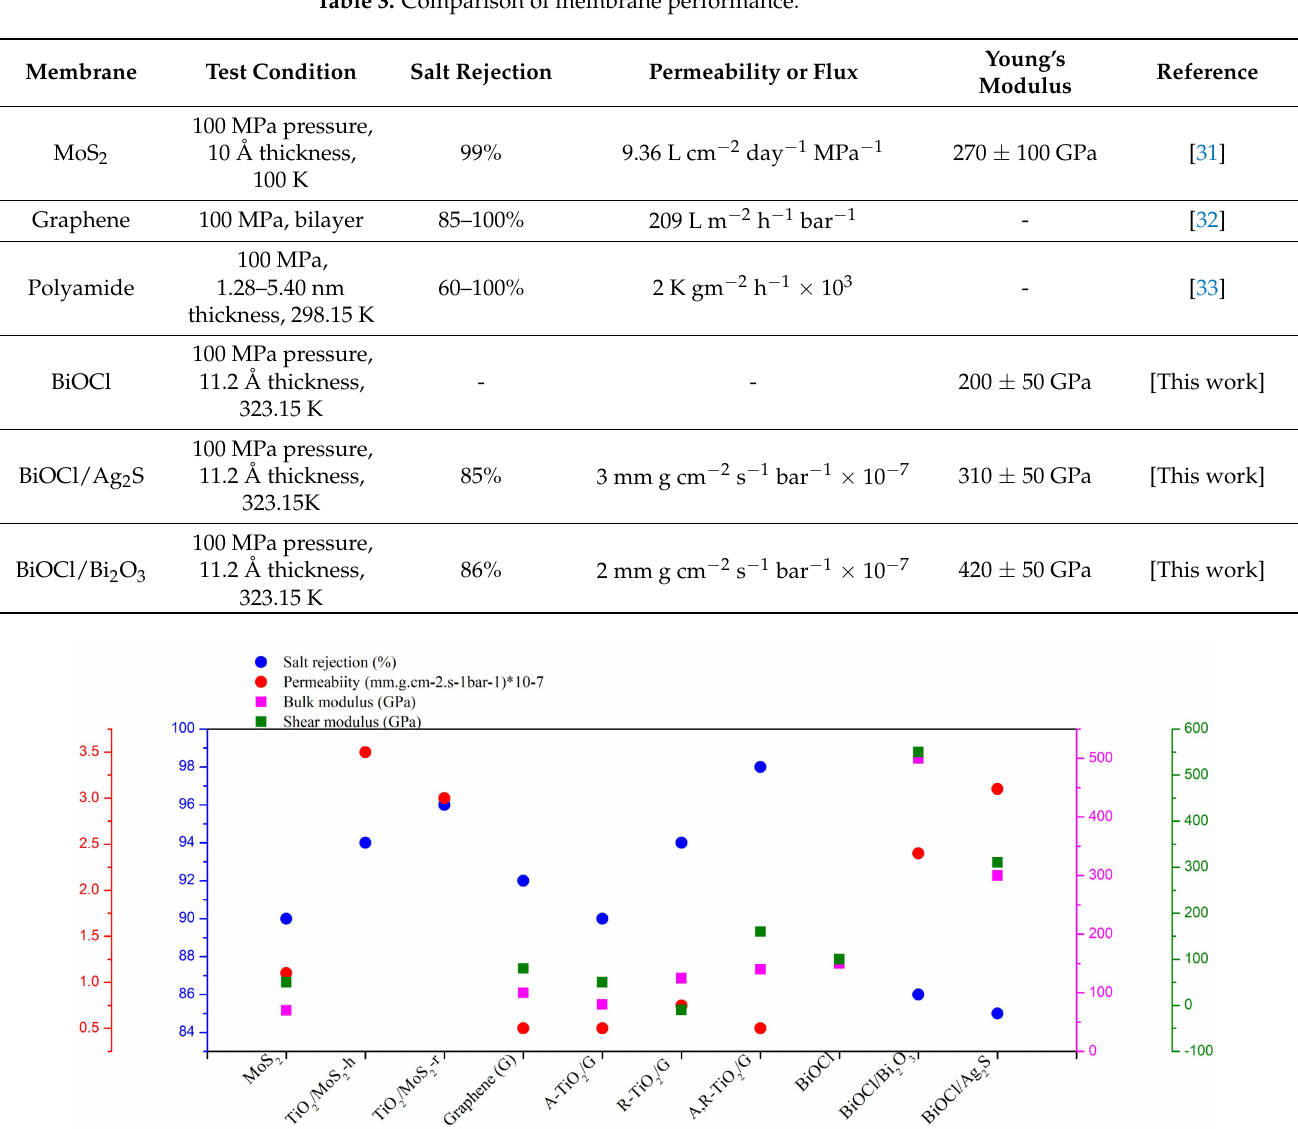
Table 3. Comparison of membrane performance.